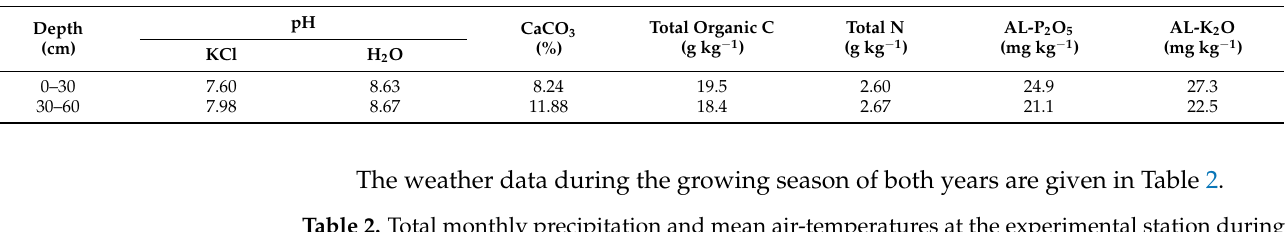
Table 2. Total monthly precipitation and mean air-temperatures at the experimental station during 2011 and